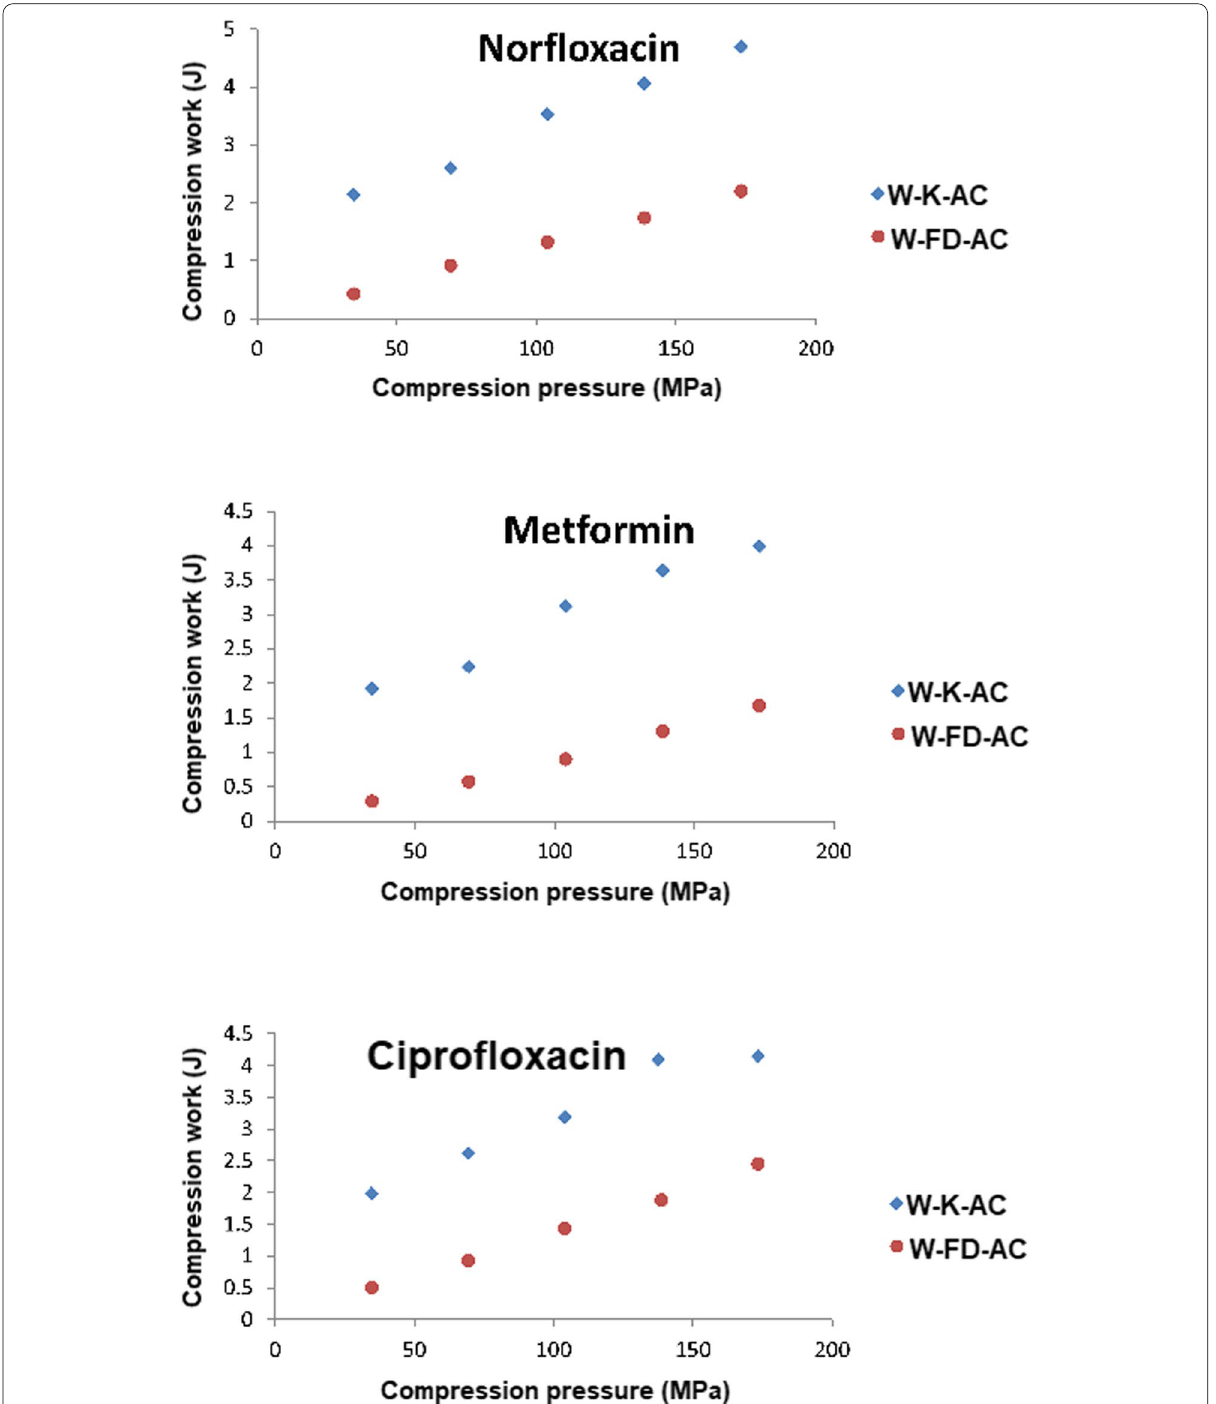
Fig. 9 Work of compression calculated using the integrated form of Kawakita equation (Eq. 4) and the F-D curve for the drugs comprising compacted norfloxacin, metformin, and ciprofloxacin all compressed at compression pressures 34–173